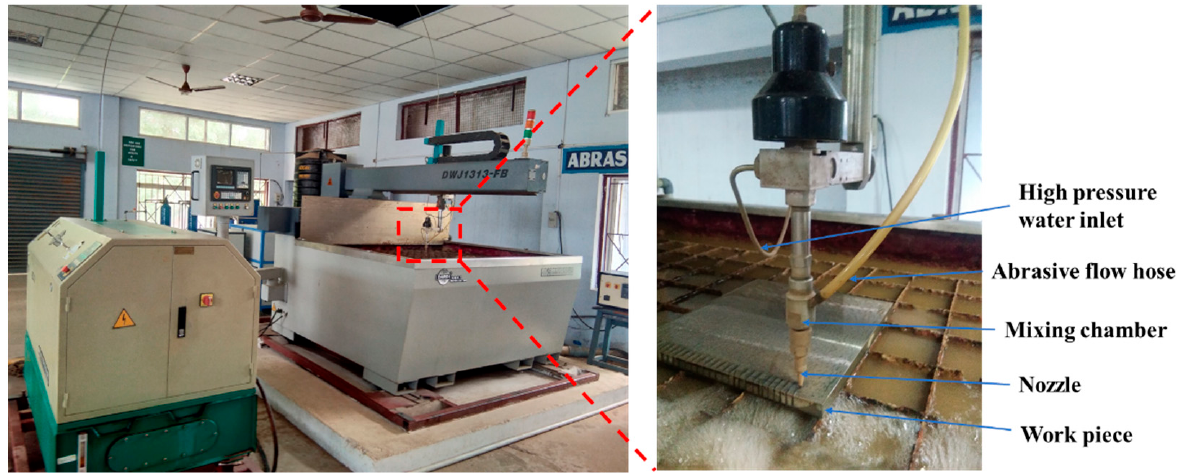
Figure 1. The experimental setup and close-up view of a workpiece mounted on the machine. AWJM trials were carried out on armor steel using M/s. DADRI International makes the DWJ FB-1313 machining center. Throughout the cutting process, the parameters of jet impact angle (90 ◦ ), garnet abrasive size (80 mesh), nozzle diameter (0.67 mm), and orifice diameter (0.25 mm) were maintained at constant. On the basis of the literature and initial experiments, the AWJM input parameters and their ranges were chosen. AWJM was used to cut a 20 mm straight linear single pass on the armor steel plate. The process parameters were varied at three levels: [P = 220, 240, 260 MPa; JT = 5, 10, 15 mm/min; and SOD = 1, 2, 3 mm]. The full factorial design was considered to conduct the